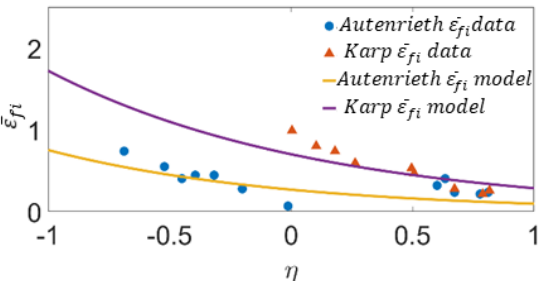
Figure 6. Fracture initiation strain predicted using Shear compression specimen under quasi-static loading, Shear specimens and compression testing as a function of stress triaxiality and fitted using an exponential function.